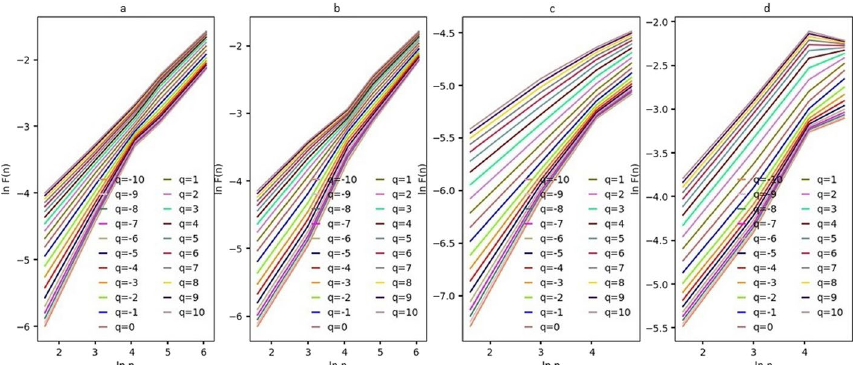
Fig. 5 MF-X-DMA summary: low capitalization of the modern Russian financial market ( a ), concentration of the banking sector ( b ), low liquidity in small cap stocks at the financial market ( c ), low financial literacy ( d ). Sources : Goskomstat (2022), Bank of Russia (2020), author’s